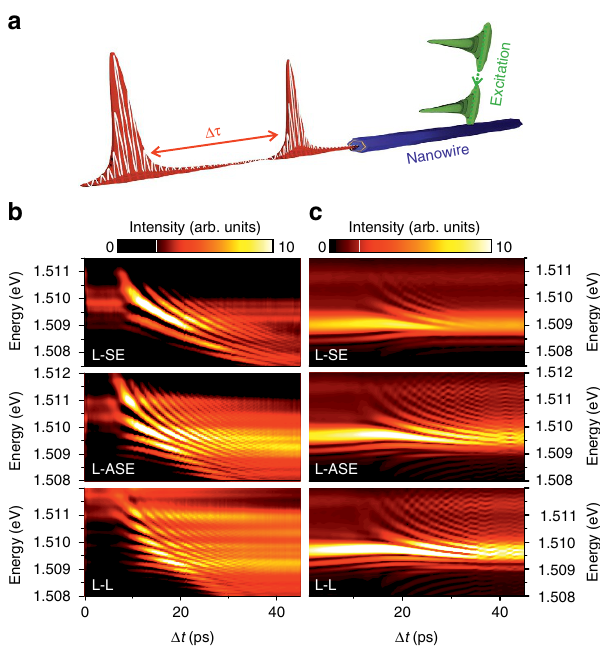
Figure 1 | Time-resolved pump–probe response of the NW laser. ( a ) Schematic illustration of a NW laser emitting a coherent pulse pair. ( b ) Optical spectra recorded as a function of the pump–probe delay D t . ( c ) Corresponding theoretical results obtained using the optical Bloch equation model described in the text. b , c depict situations for a fixed pump pulse power in the lasing regime and three different probe pulse powers: L-SE: probe pulse in the spontaneous emission regime (probe pulse power P probe B 0.6 (cid:3) P th ), L-ASE: probe pulse in the amplified spontaneous emission regime ( P probe B 1.9 (cid:3) P th ) and L-L: probe pulse in the lasing regime ( P probe B 4.7 (cid:3) P th ). The data are plotted on a linear colour scale.